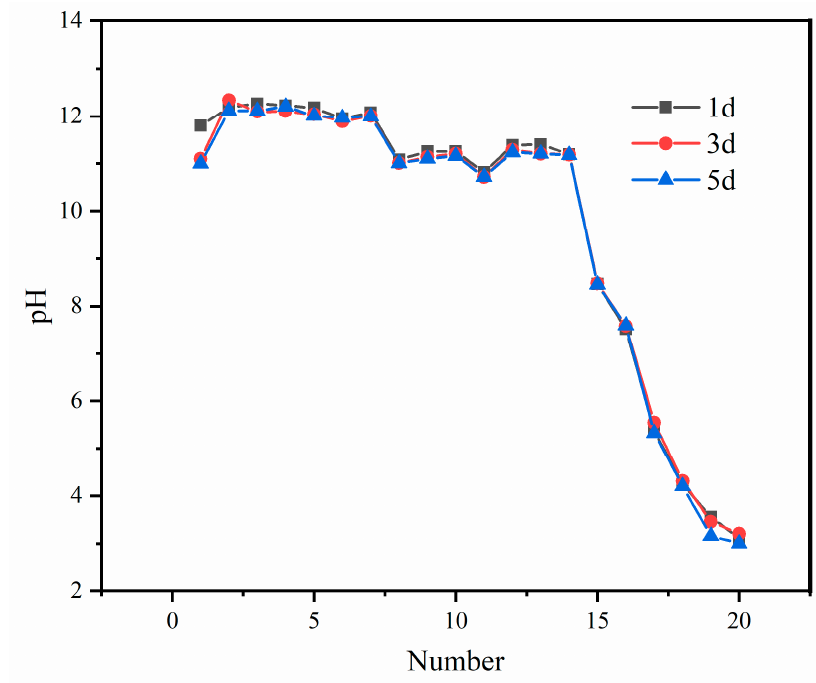
Figure 5. pH of PG after neutralization.